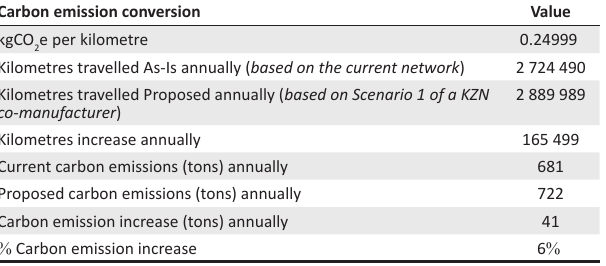
TABLE 13: Source case study scenario 3: Overall carbon emission reduction. Carbon emission conversion